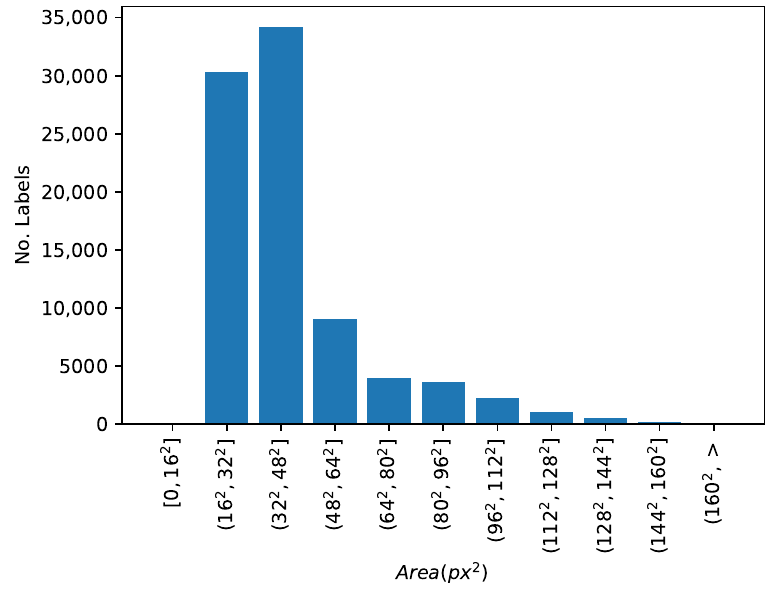
Figure 4. Distribution of the labels according to the area in pixels 2 for an image size of 416 × 416